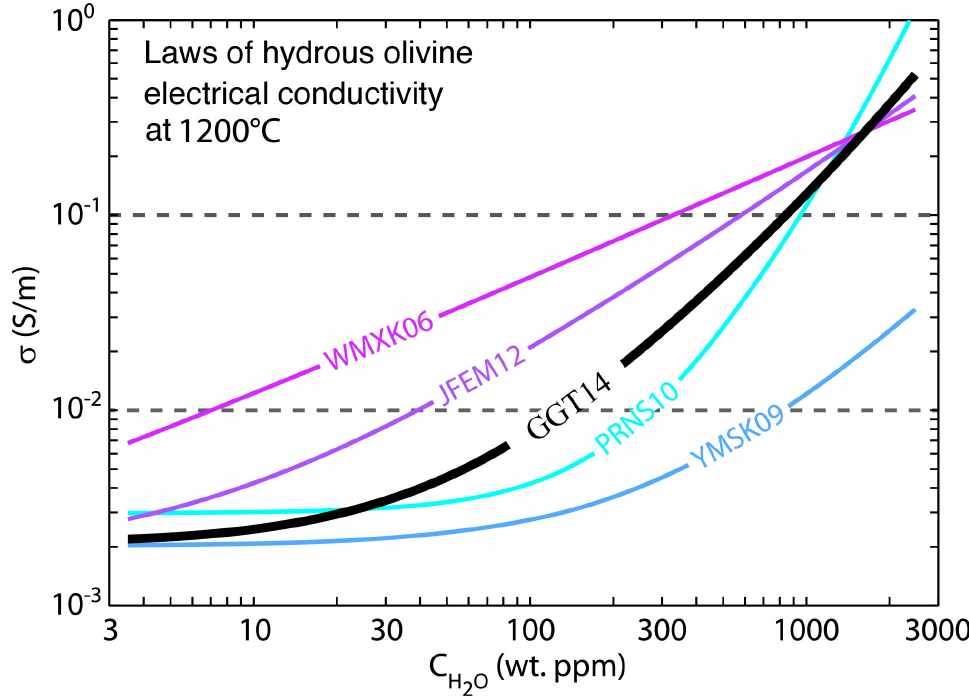
Figure 3. The effect of water on the conductivity of olivine at 1200 ◦ C from various laboratory mea- surements (modified after Gardès et al. [58]). WMXK06:Wang et al. [54]; YMSK09: Yoshino et al. [45]; PRNS10: Poe et al. [56]; JFEM12: Jones et al. [59]; GGT14: Gardès et al.